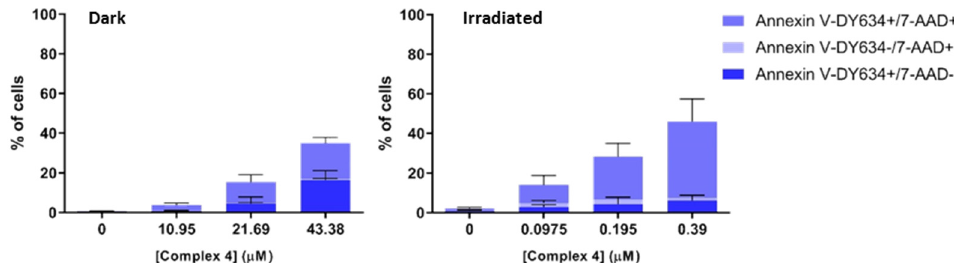
Figure 6. Cytotoxicity assays of complex 4 , when it was incubated in A549 cell line for 24 h, in a range of concentration between its IC 50 and ¼ IC 50 values. In dark ( left ); Under irradiation at 470 nm ( right ).